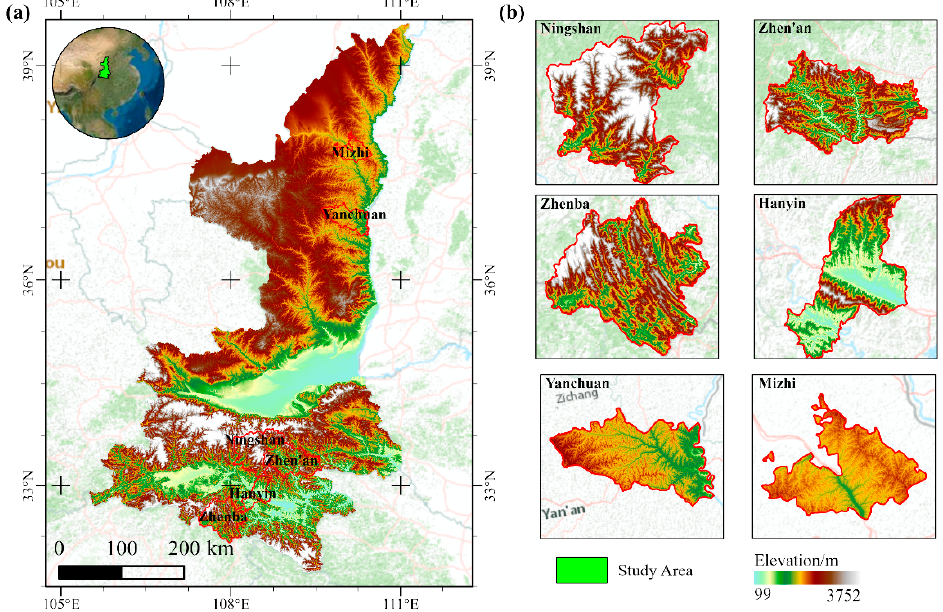
Figure 2. Study area and typical sample areas: ( a ) the overview of the study area; ( b ) the locations of the six typical sample areas in the DEM imageries. the six typical sample areas in the DEM imageries.